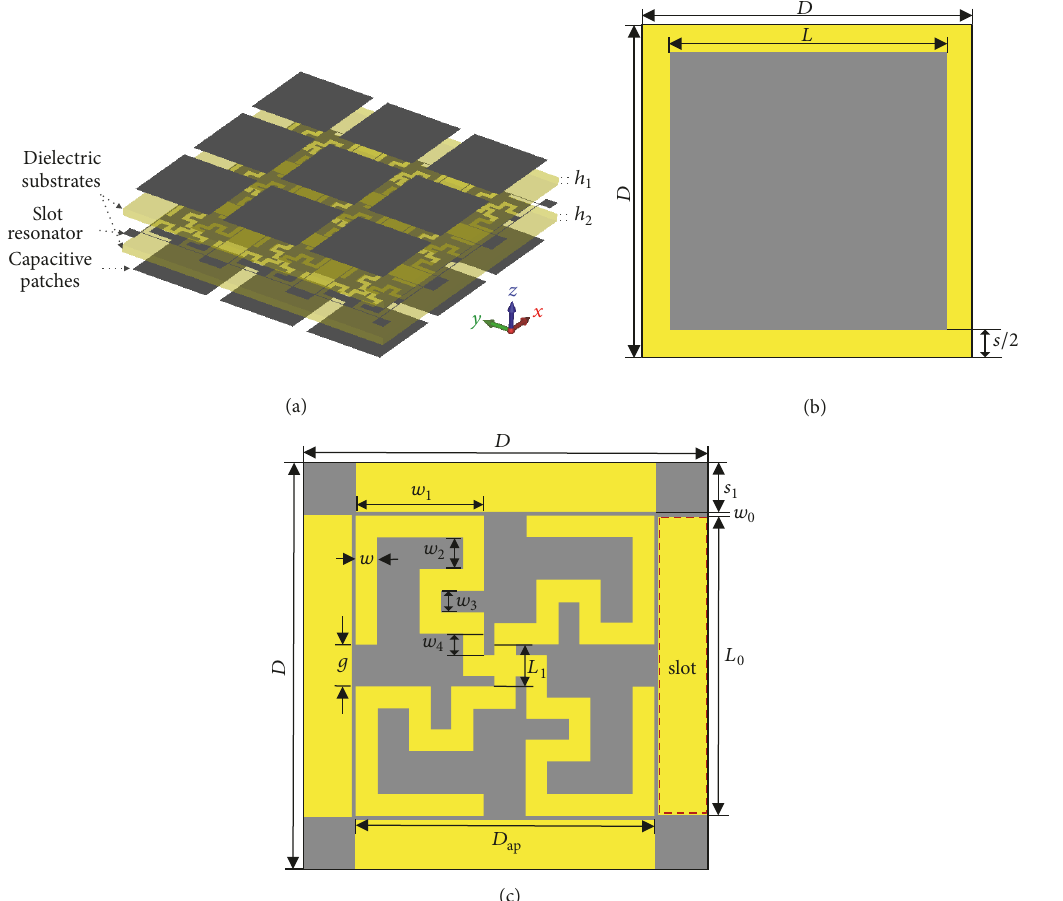
Figure 1: Topology of the proposed FSS. (a) The 3D view of the dual-band FSS; (b) the unit cell on the top and bottom layer; (c) the unit cell on the middle